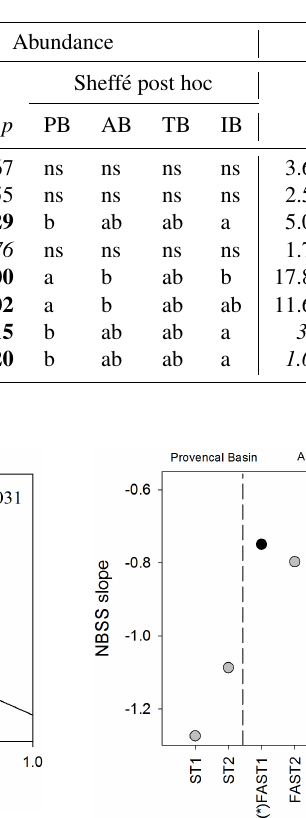
Table 4. Results of the one-way ANOVA tests performed to test differences between areas (PB, AB, IB, and TB) with respect to the abundance and biomass data for the different zooplankton size classes, for total zooplankton (all size classes), and for mesozooplankton (ESD between 200 and 2000µm) between the areas. Significant differences ( p value < 0 . 05) are marked in bold. “ns” denotes no significant difference. Italic F and p values mark where a Dunnett’s test was used. In the post hoc analysis, the homogeneous groups with the lowest and highest values are noted using “a” and “b”, respectively. PB refers to Provencal Basin, AB refers to Algerian Basin, TB refers to Tyrrhenian Basin, and IB refers to Ionian Basin.